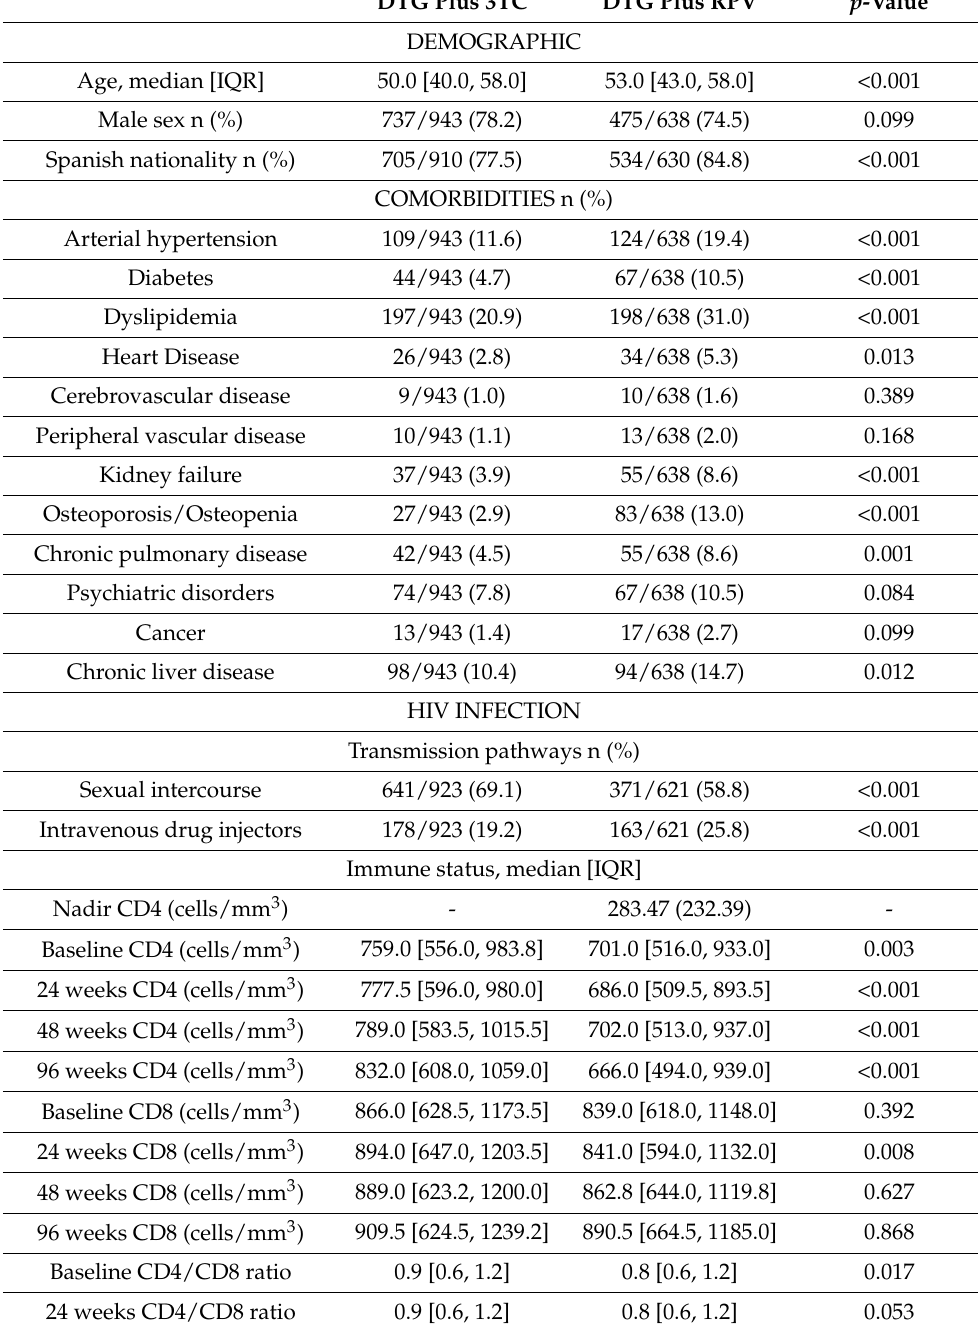
Table 1. Demographic characteristics, comorbidities, HIV infection, and possible co-infections according to treatment. Comparison between the two